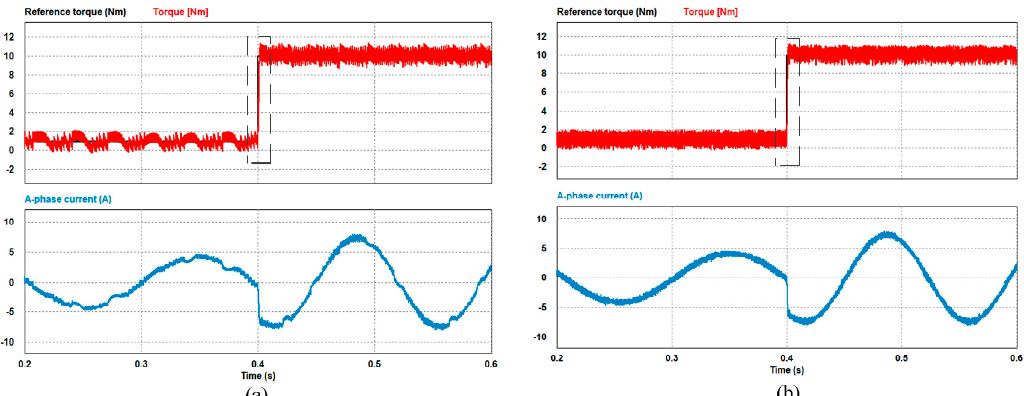
Figure 5. Simulation results of dynamic torque performance for CFTR-DTC with ( a ) single carrier and ( b ) interleaving carriers.